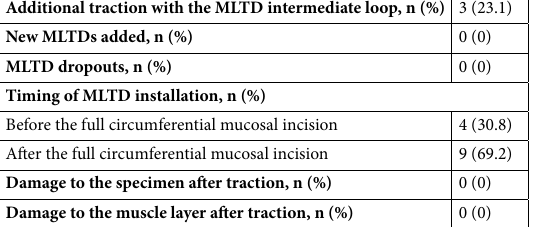
Additional traction with the MLTD intermediate loop, n (%) 3